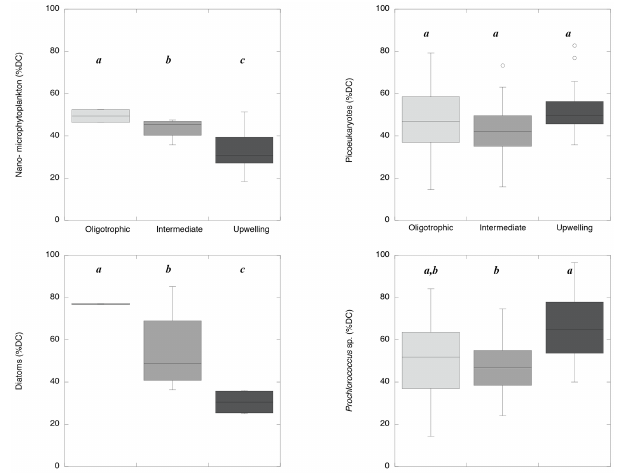
Figure 3. Box plots showing the abundance distribution of the pi- coplankton populations within systems. The boxes show the lower and upper quartiles, median, minimum, and maximum values, and outliers. Numbers correspond to averaged ( ± SE) abundances within systems. The boxes connected by same letter are not signifi- cantly different (Wilcoxon signed-rank test, p < 0 . 05).